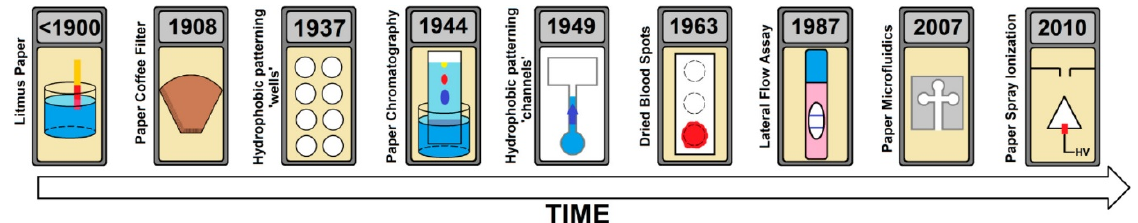
Figure 4. A history of paper in science, highlighting important milestones. Reprinted from [57] (open access, https://pubs.acs.org/doi/10.1021/acs.analchem.8b04825 accessed on 16 February 2021, further permissions should be directed to the ACS).